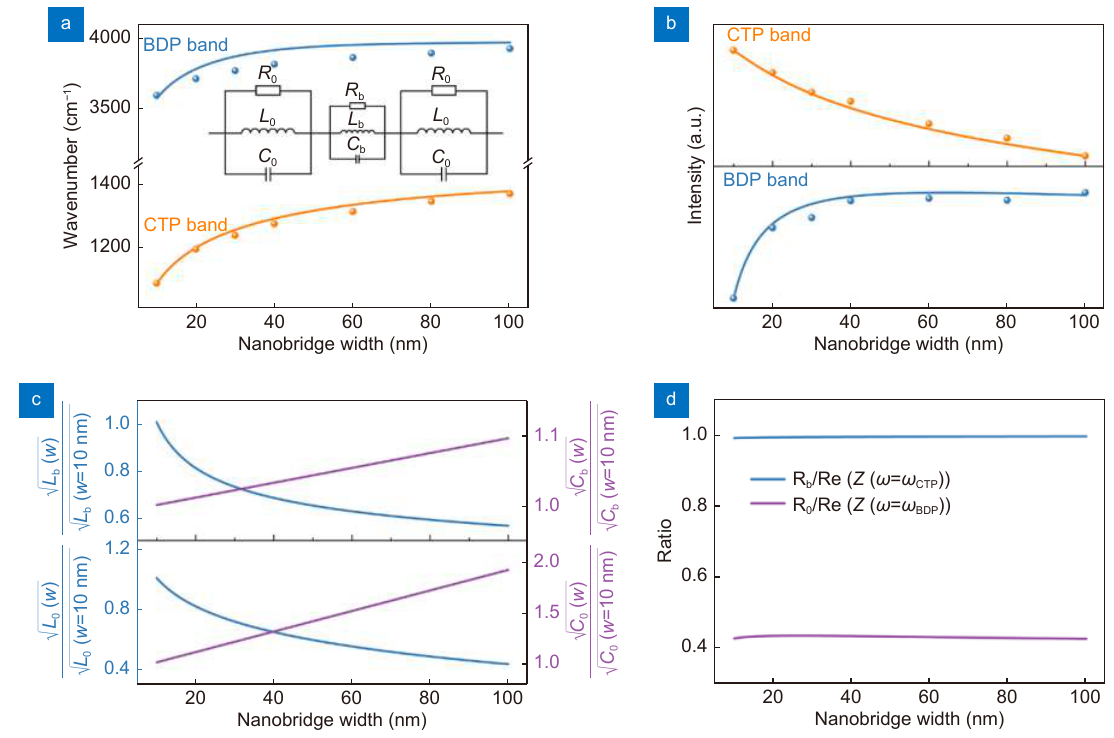
Fig. 4 | Nanobridge width-dependent ( a ) resonant frequencies and ( b ) intensities of CTP and BDP bands. The orange and blue circles are extrac- ted from the simulated extinction spectra (Fig. 3(a)), while the points on the fitting curves are extracted from the spectra of (Fig. S12, Supplementary information). Inset in (a): RLC circuit model of the NBRA structure. ( c ) Nanobridge width-dependent ratio of (blue curve in the top panel), (purple curve in the top panel), (blue curve in the bottom panel) and (purple curve in the bottom panel). (d) Nanobridge width-dependent ratio of (blue curve) and (purple curve). and are the deterministic parameters for .